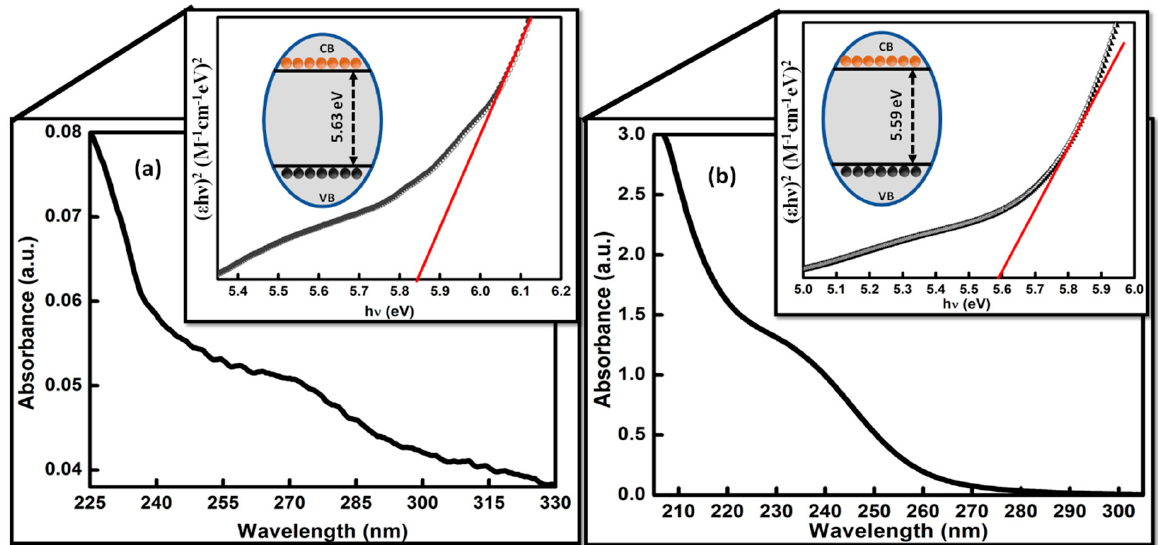
Figure 4. ( a , b ) UV-vis. spectra and (inset ( a , b )) showing the band gap of MPTMS@Gd 2 O 3 NPs and Cys, respectively. Cys,